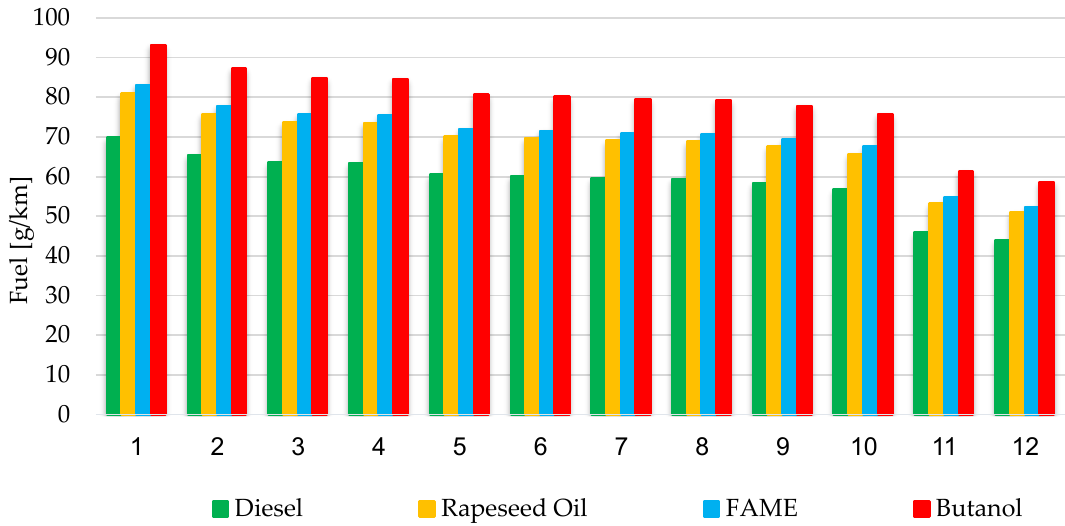
Figure 12. Summary of fuel mass consumption in tests per 1 kilometer: 1—Random Cycle High (x95); 2—FTP 75; 3—US SC03; 4—US 06; 5—NEDC; 6—CADC; 7—WLTC 3b random; 8—CADC without MOT; 9—CADC shortened; 10—Random Cycle Low (x05); 11—MAC TP cycle; 12—US highway.